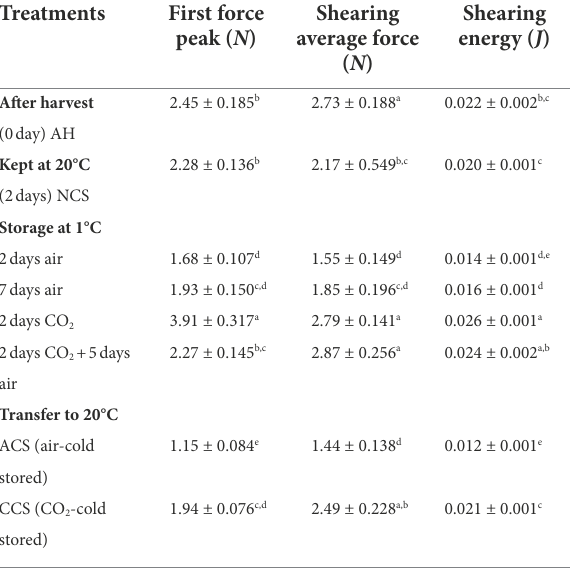
TABLE 1 Mechanical parameters derived from Volodkevich force- distance curves.